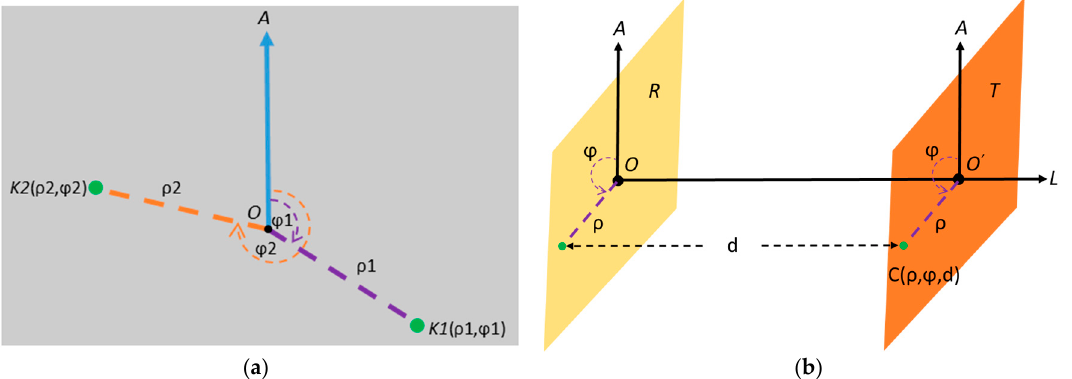
Figure 3. Two-dimensional (2D) polar coordinate system ( a ) and three-dimensional (3D) cylindrical coordinate system ( b ). coordinate system ( b